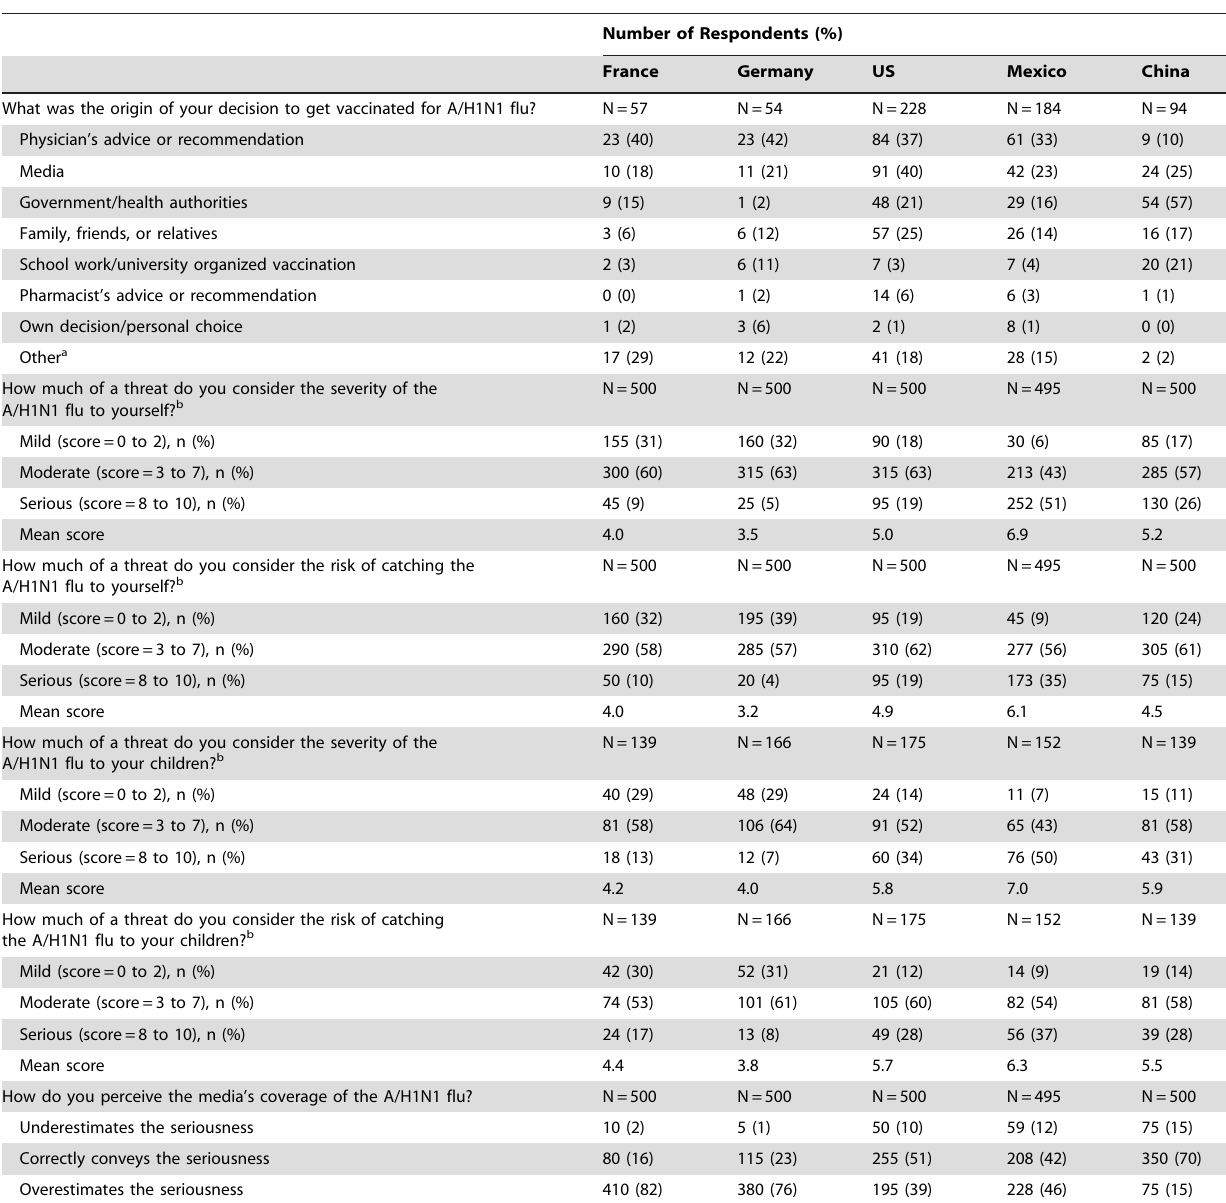
Table 2. General public opinions of A/H1N1 pandemic influenza and vaccination for it.